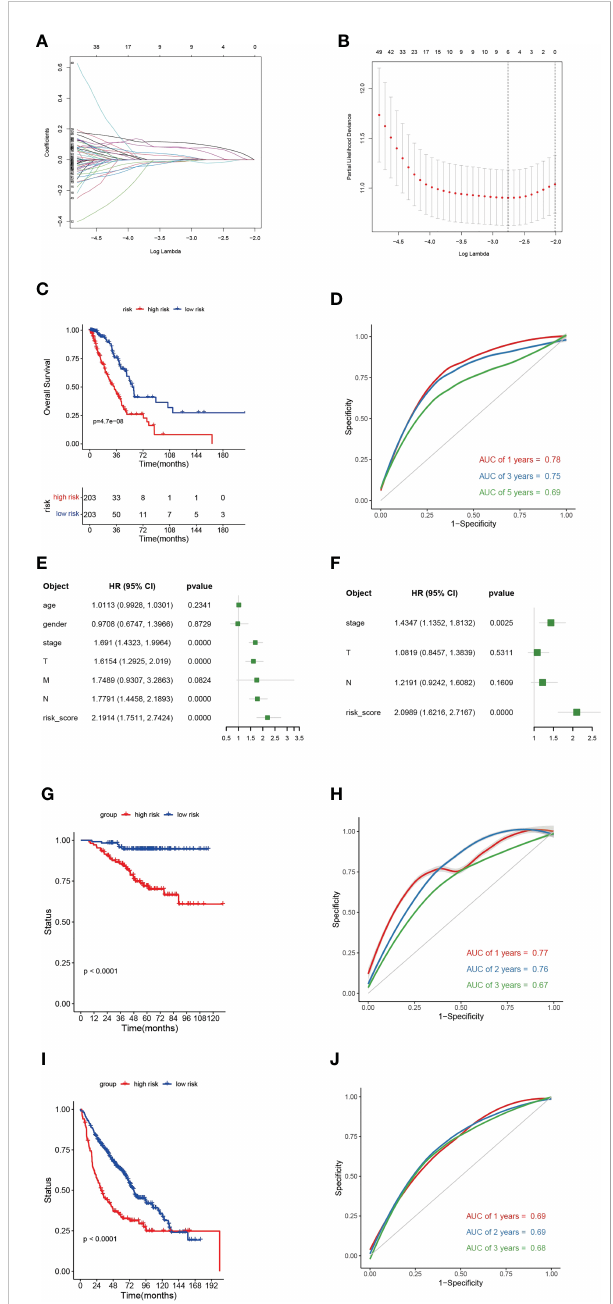
FIGURE 7 A 6-gene risk model based on differentially expressed genes (DEGs) between clusters (A) and (B, A) Partial likelihood deviance coef fi cient pro fi les. (B) Least absolute shrinkage and selection operator cox analysis of the DEGs between clusters A and (B, C) Kaplan-Meier curves for overall survival (OS) of the high- and low-risk subtypes in TCGA-LUAD cohort. (D) Receiver operating characteristic (ROC) curves for 1-, 2- and 3-year of TCGA-LUAD cohort. (E) Multivariate cox regression analyses show the hazard ratios of 6-gene risk model and other clinic-pathological factors. (F) Univariate cox regression analyses show the hazard ratios of the risk model and other clinic- pathological factors. (G) Kaplan-Meier curves for OS of the high- and low-risk subtypes in GEO-LUAD cohort (GSE31210). (H) ROC curves for 1-, 2- and 3-year of GEO-LUAD cohort